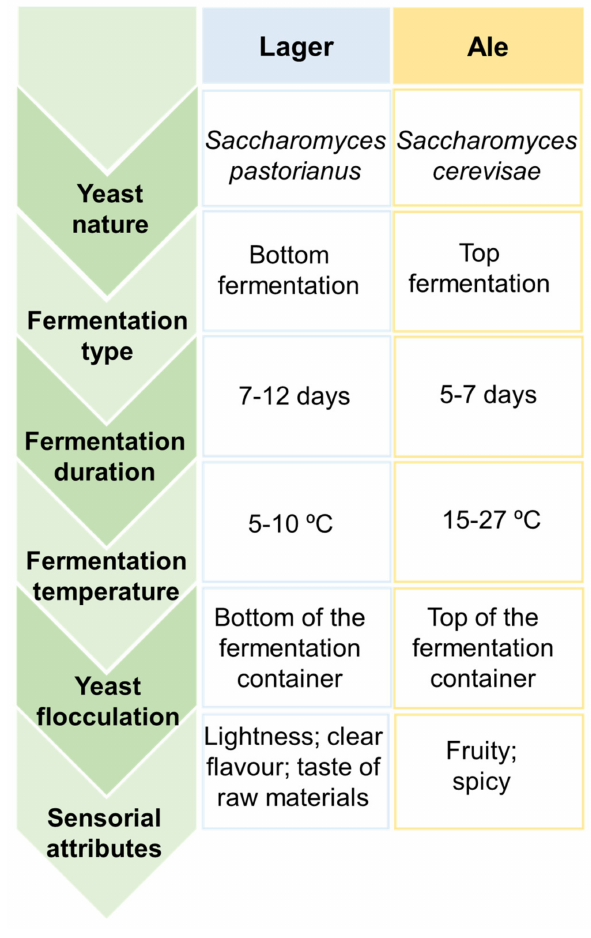
Figure 2. Main differences between Lager and Ale